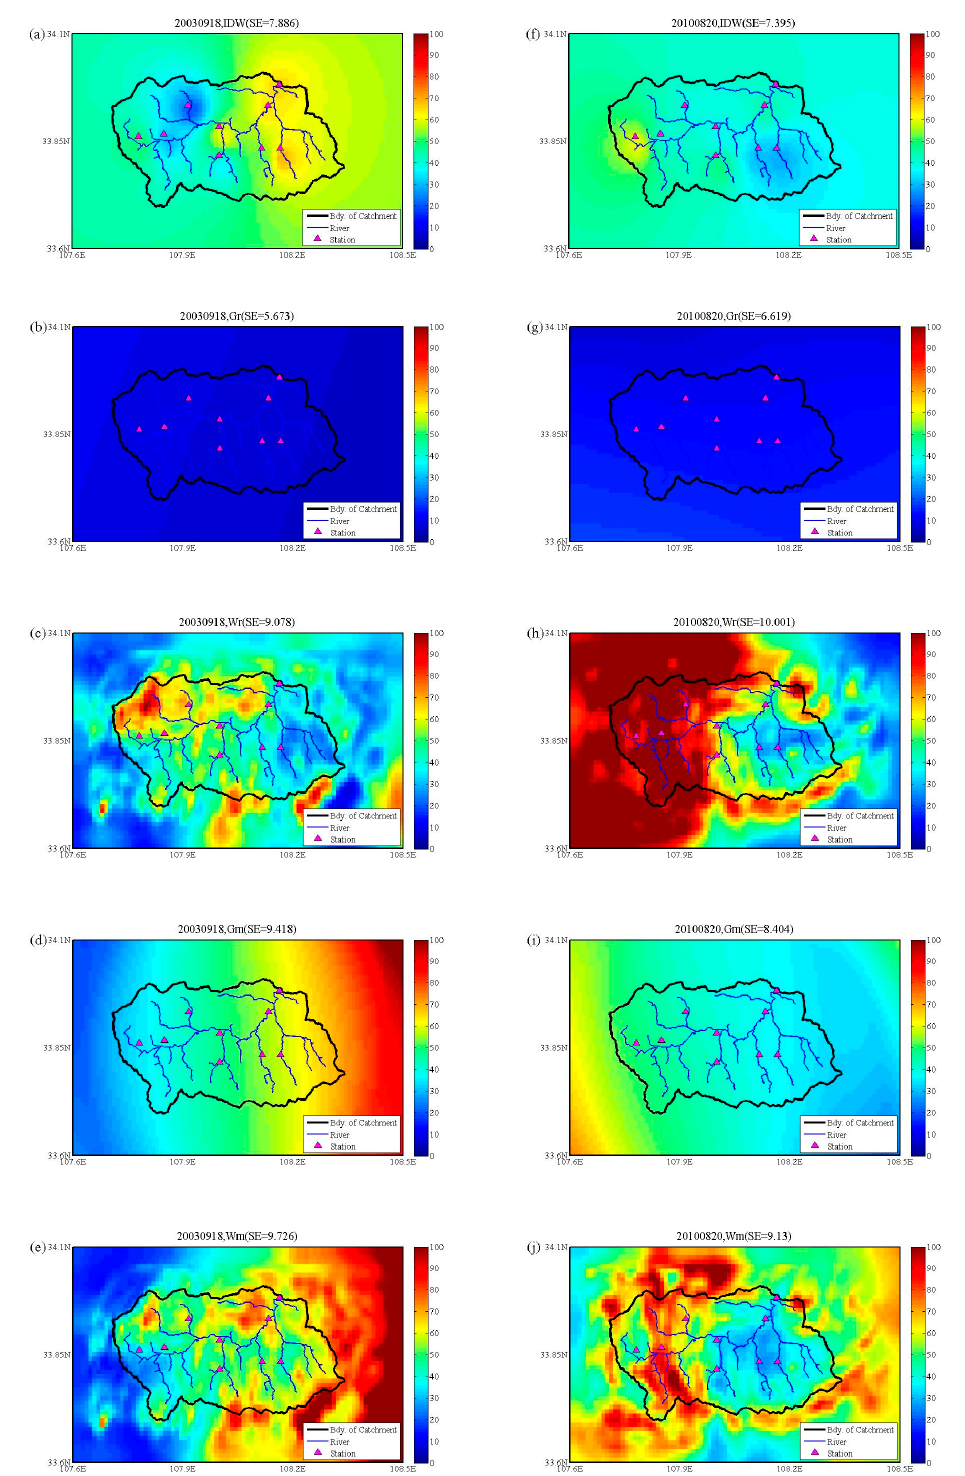
Figure 5. Spatial distribution of cumulative rainfall on the highest rainfall day from IDW, Gr, Gm, Wr and Wm from top to bottom in terms of 030916, ( a )–( e ), and 100820, ( f )–( j ). (Unit: mm). To further illustrate the impact of merging method on the spatial distributions of the rainfall products, we also calculated the PB and RMSE of Gr, Gm, Wr and Wm based on the cumulative rainfall on the highest rainfall day at 9 rain gauges for all events (Figure 6). The PB-distributions of the Gm and Wm narrow around 0-line, and the majority of RMSE-values decline from above 50 mm (68.4% and 63.2% for the Gr and Wr, respectively) to below 50 mm (84.2% and 68.4% for the Gm and Wm, respectively). Therefore, the accuracy and spatial variability have been improved after merging